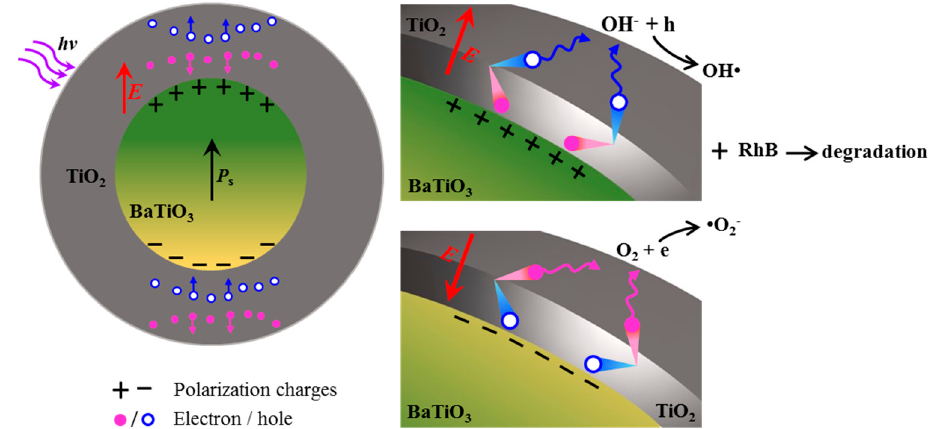
Figure 3. The schematic illustration of charge separation and transport facilitated by polarization-induced internal field and photodegradation of RhB based on the BaTiO 3 -TiO 2 core-shell heterostructures.